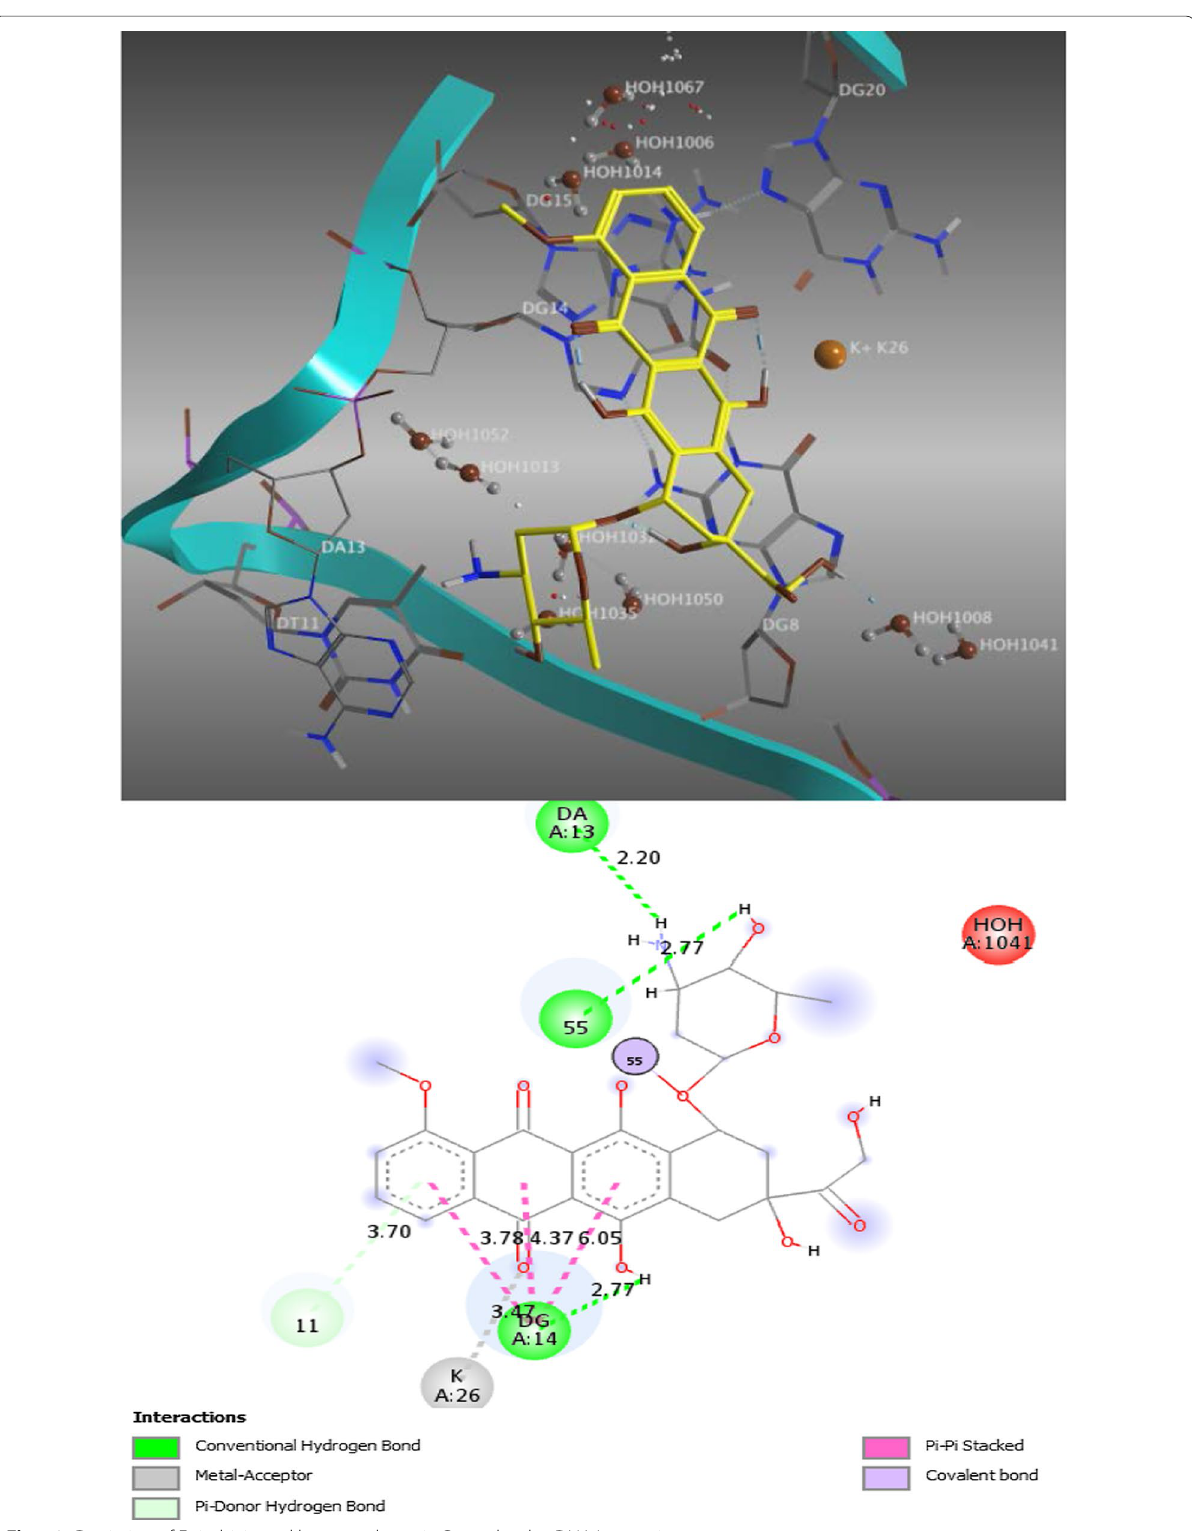
Fig. 19 Depiction of Epirubicin and human telomeric G-quadruplex DNA